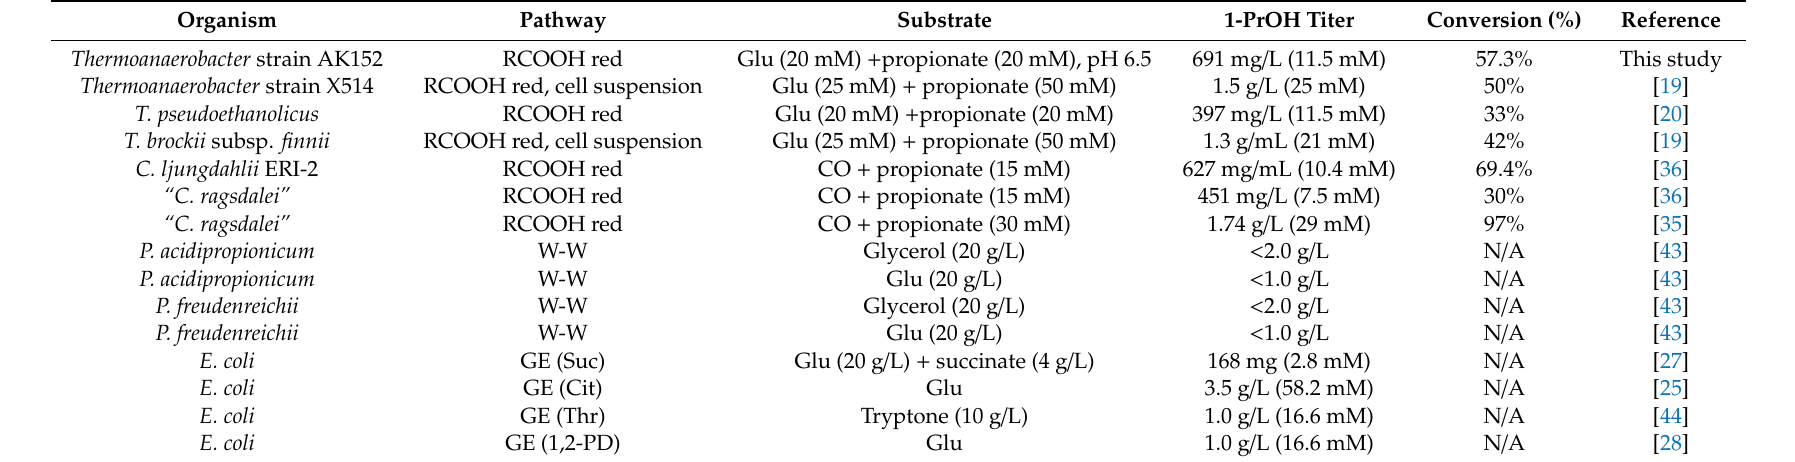
Table 1. Yields of 1-Propanol from selected organisms; red- reduction; GE-genetically engineered; Glu- glucose; W-W – Wood-Werkman pathway, Suc-succinate pathway, Cit-Citramalate pathway, Thr- Threonine pathway, 1,2-PD- 1,2-propanediol